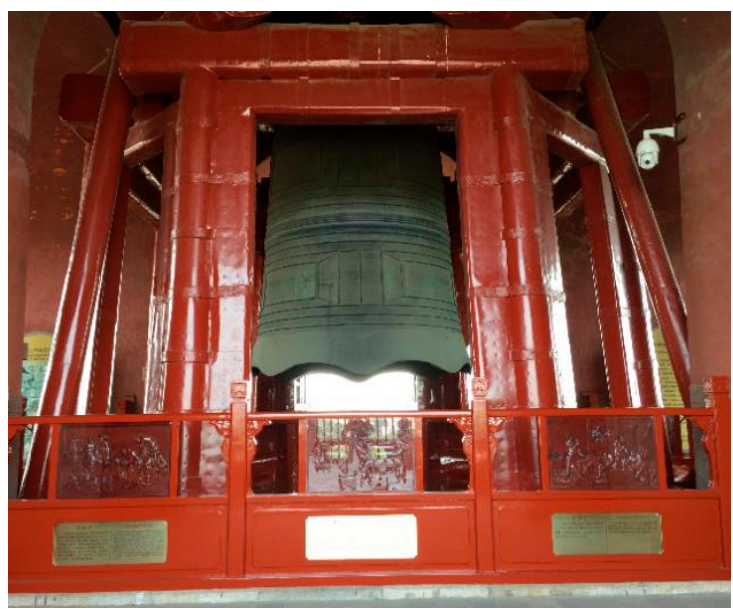
Figure 4. Bronze bell on the second floor of the Bell Tower [52].